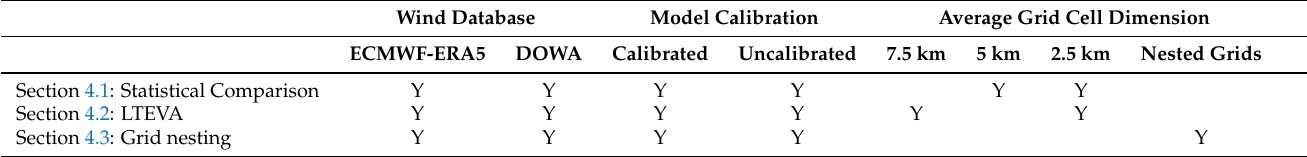
Table 1. Various model features investigated.